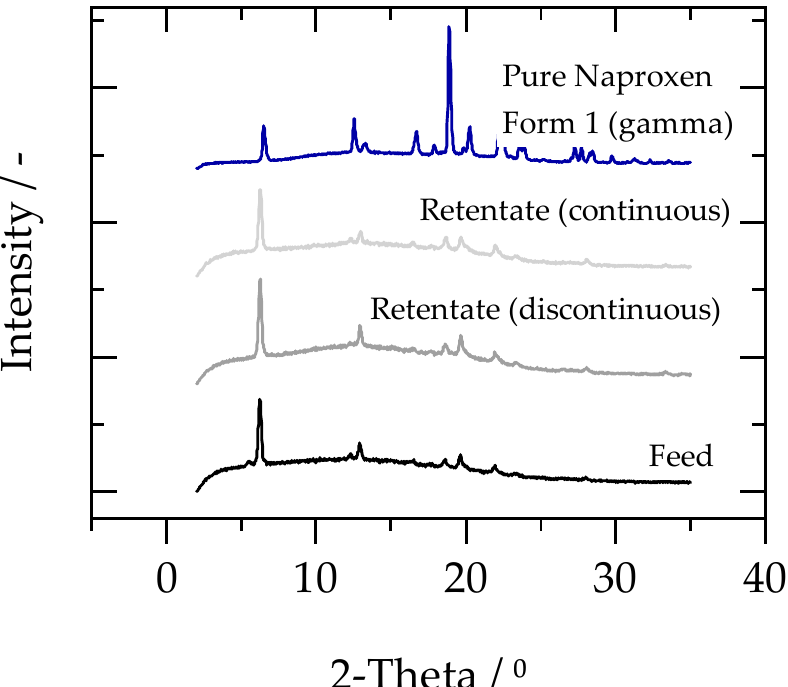
Figure 7. X-ray powder diffraction patterns of pure naproxen powder form 1 (blue), naproxen in dried feed (black), retentate of discontinuous diafiltration (grey) and retentate of semi-continuous diafiltration (light grey).